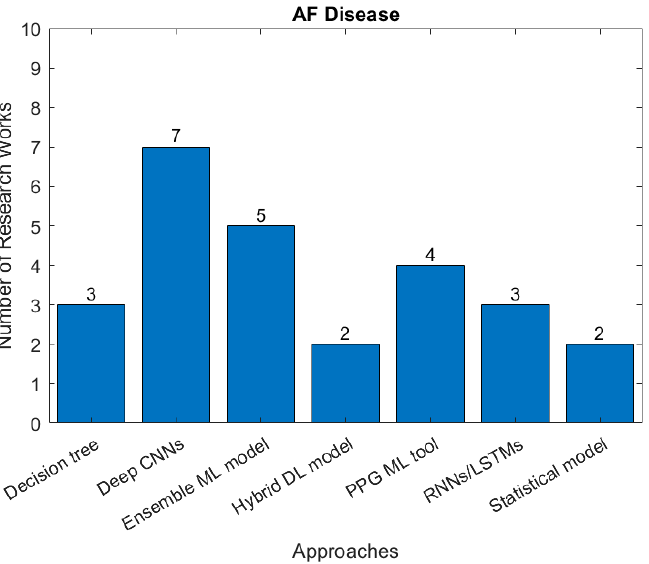
Figure 8. The number of studies applying each type of AI models for detection of AF (there are 14 papers related to ML, 12 related to DL in the identified papers between January 2018 and April 2022).